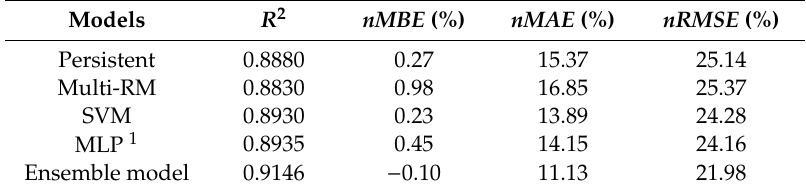
Table 5. The performance of different models for predicting inter-hour GHI on the testing set. Models